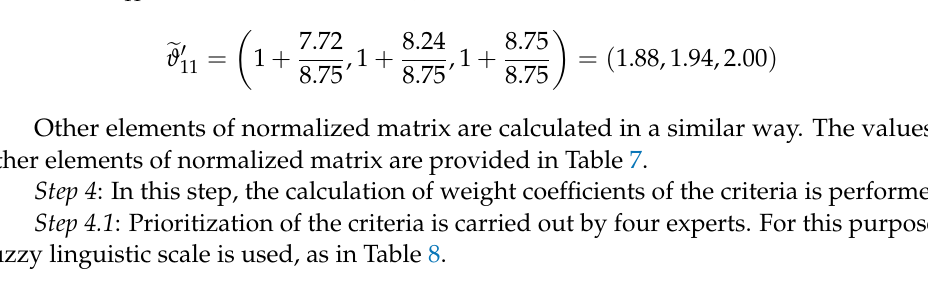
Table 7. Normalized decision-making